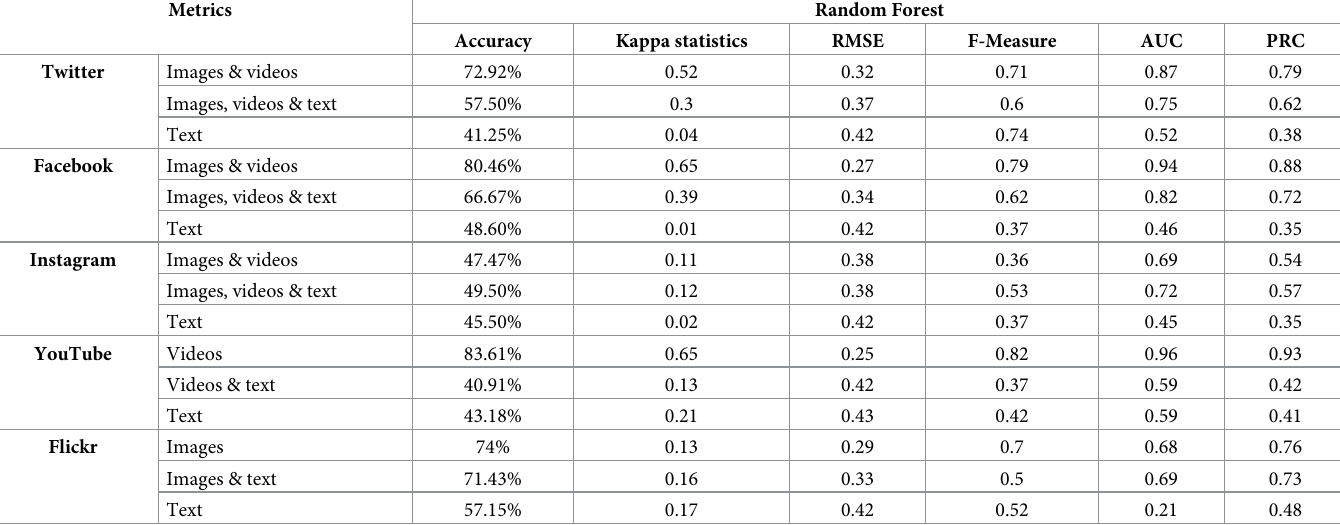
Table 5. Random forest classifier accuracy for data quality of different social media